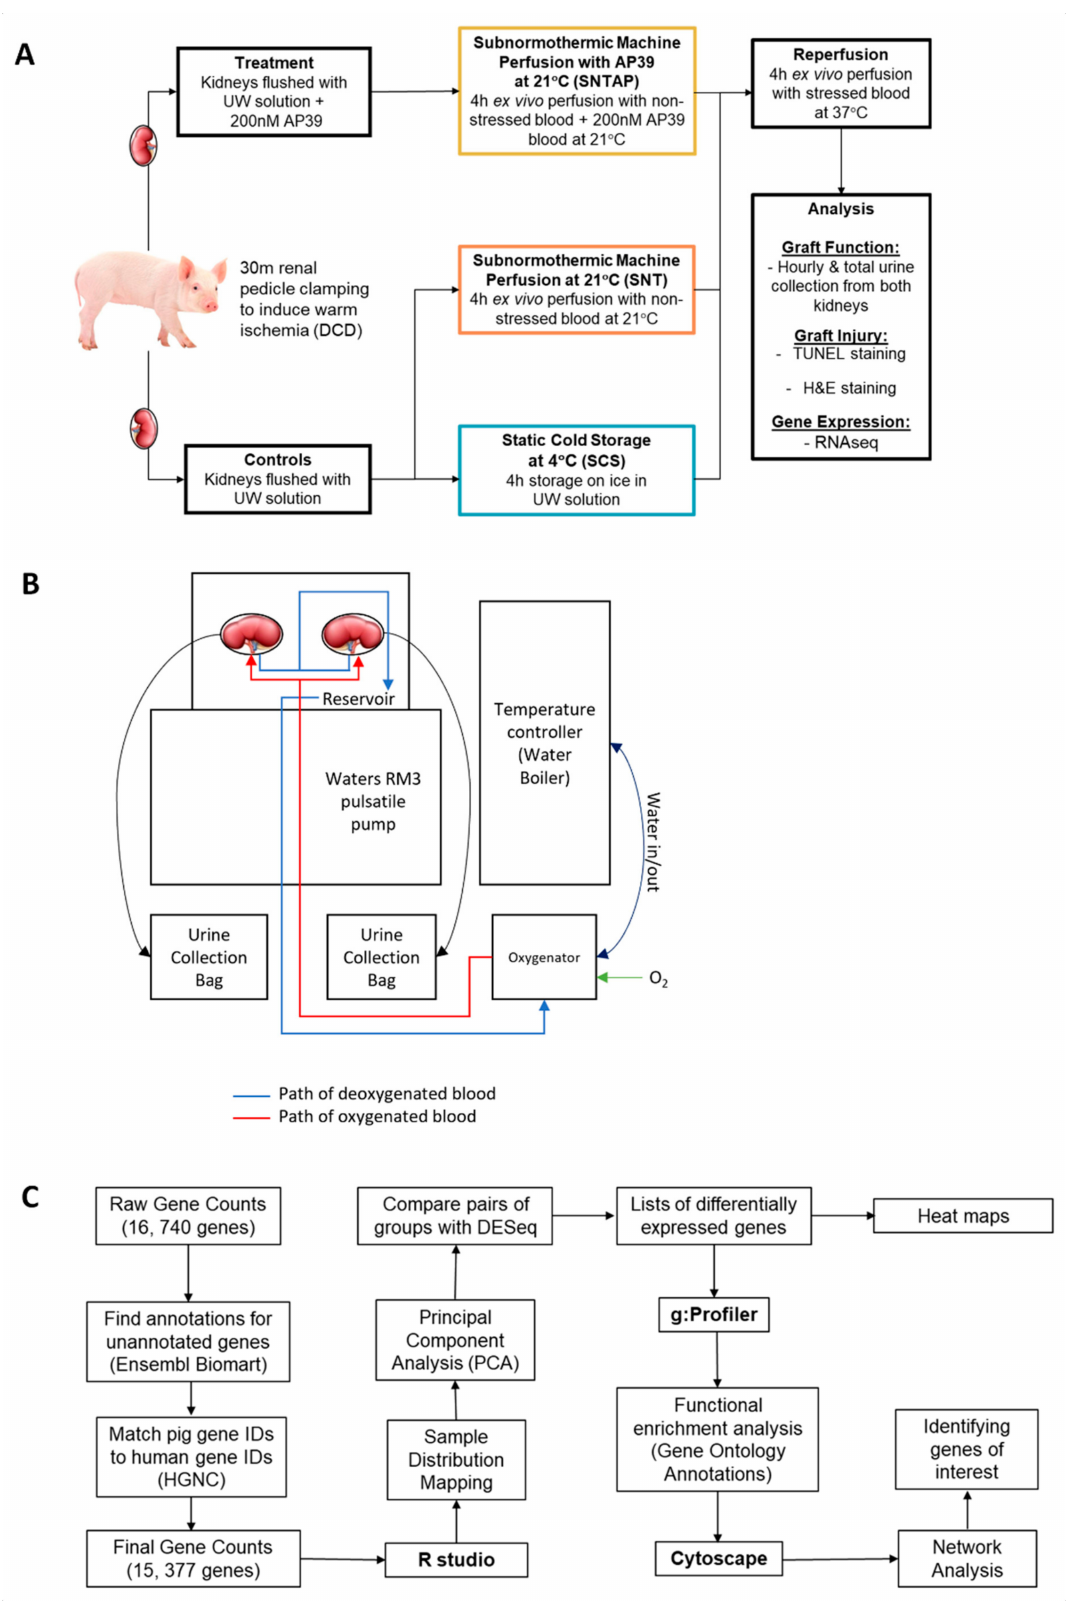
Figure 1. Summary of the methods. ( A ) Overview of the experimental design. ( B ) Schematic of the ex vivo perfusion setup used for porcine kidney perfusion and reperfusion. ( C ) RNAseq analysis